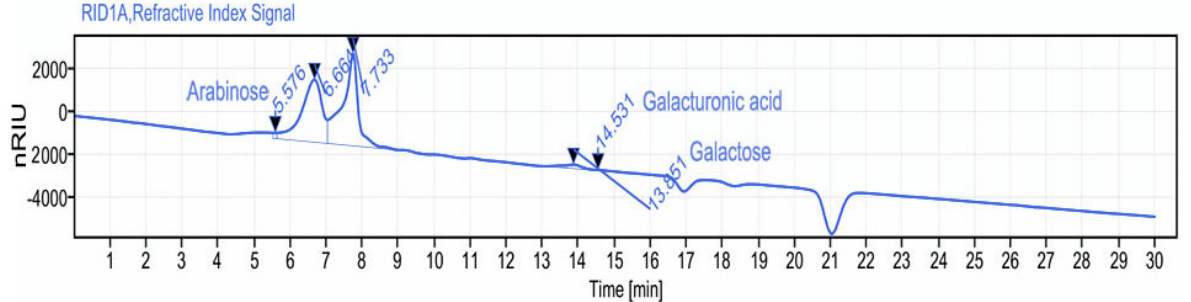
Figure 4. Monosaccharide composition analysis by HPLC − FID of PSGS.